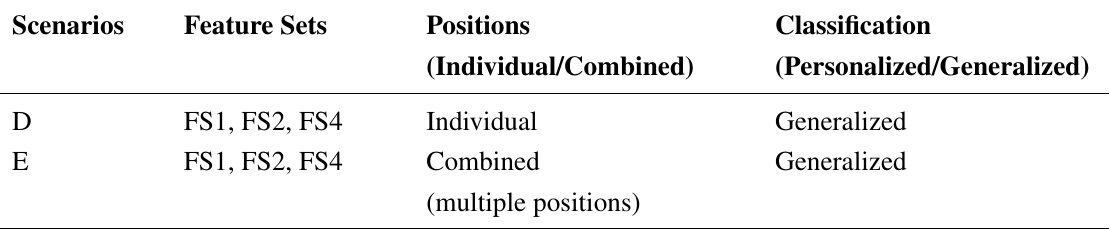
Table 9. Evaluation scenarios for the linear acceleration